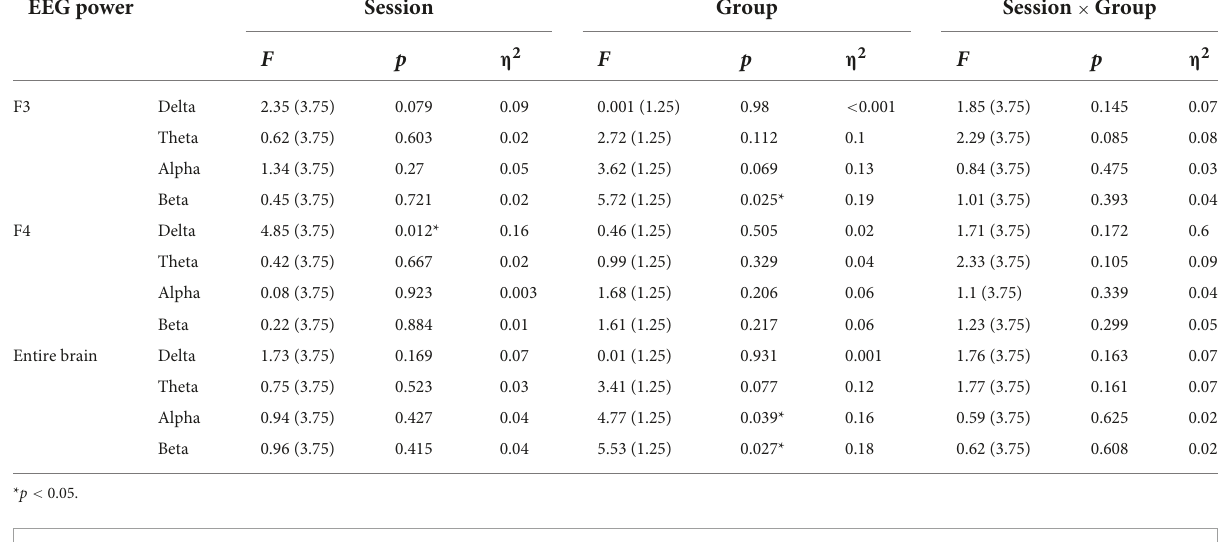
TABLE 3 Results of analysis of variance (ANOVA) on normalized values of EEG power within the delta, theta, alpha, and beta bands at electrodes F3, F4, and the entire brain. EEG power